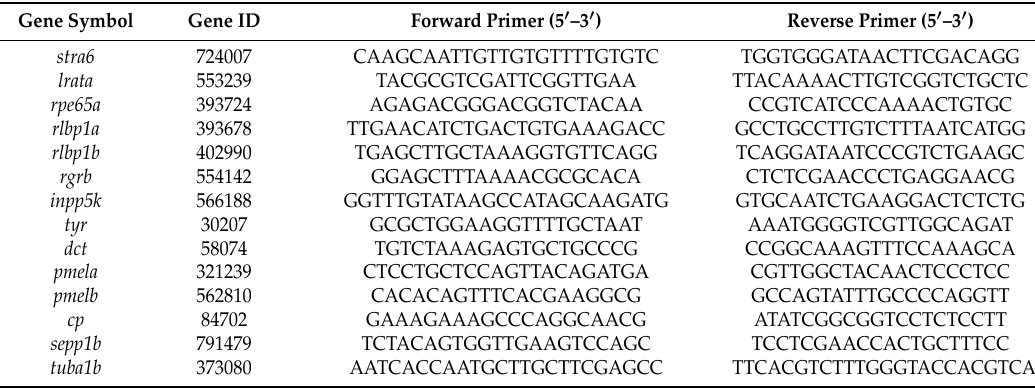
Table 2. List of primers used for qPCR